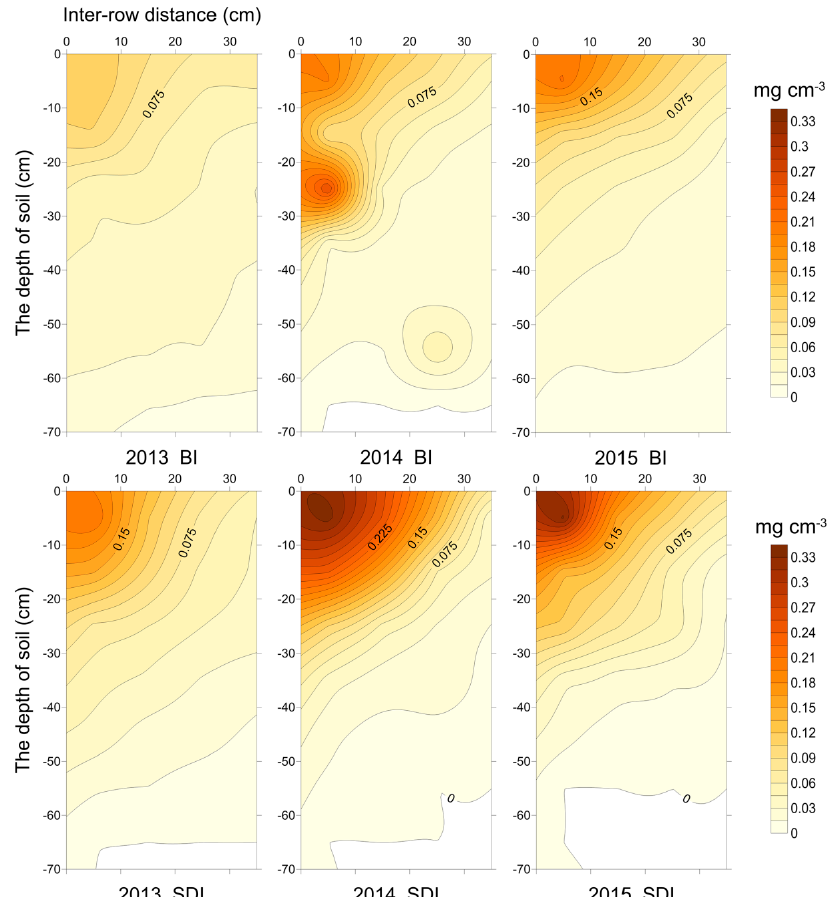
Figure 7. Two-dimensional RBD of transplanted cotton. Abbreviations: BI, border irrigation; SDI, surface drip irrigation; and RBD, root biomass density.